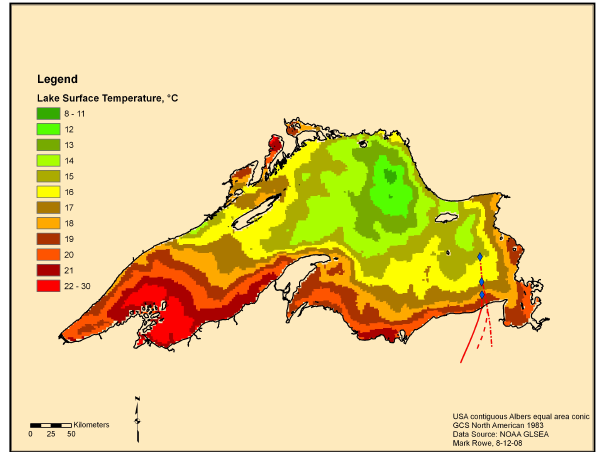
Fig. 1. A map of Lake Superior showing the station locations (dia- monds), NOAA HYSPLIT air parcel backward trajectories (lines), and NOAA GLSEA lake surface temperatures for 14 July